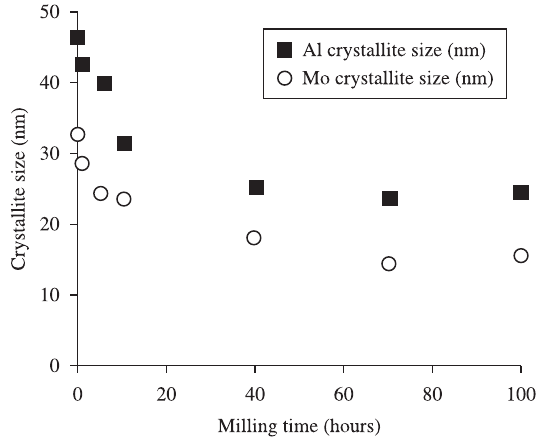
Figure 5. Crystallite size of Mo and Al as a function of milling time, calculated by Scherrer’s formula.